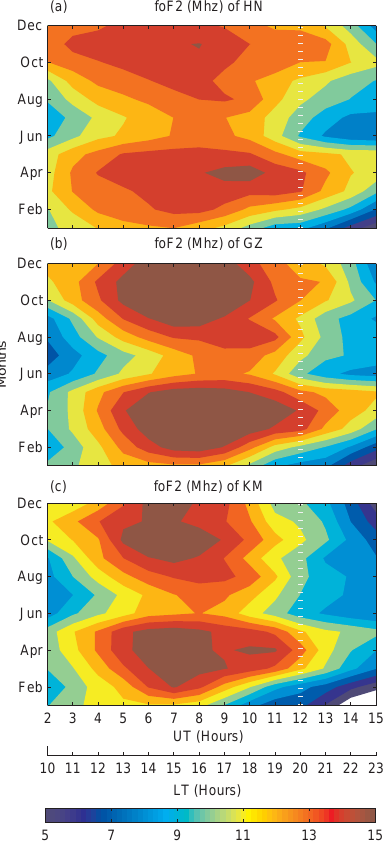
Figure 5. The contours of the monthly mean fo F2 (MHz) as a func- tion of time and season at the three stations in 2013. The white dotted line indicates